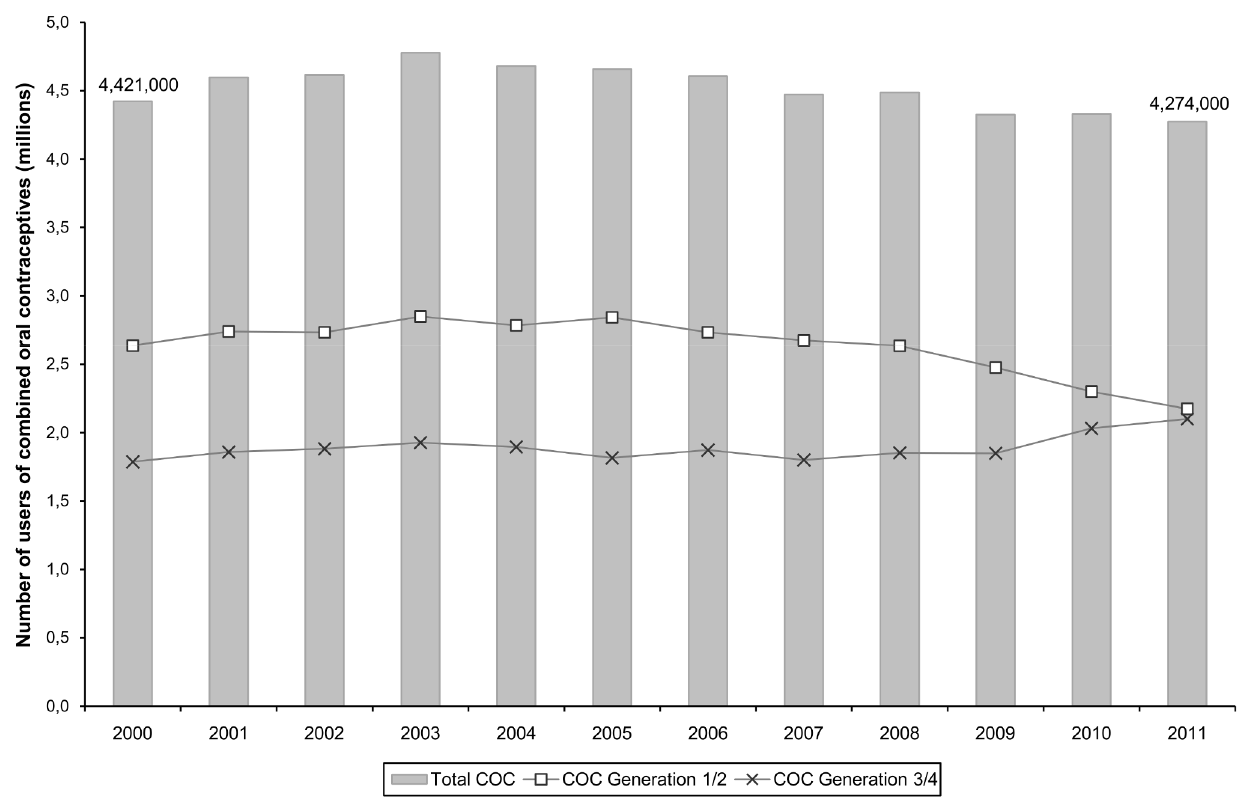
Figure 1. Exposure of combined oral contraceptives, overall and by generation, in France from 2000 to 2011.